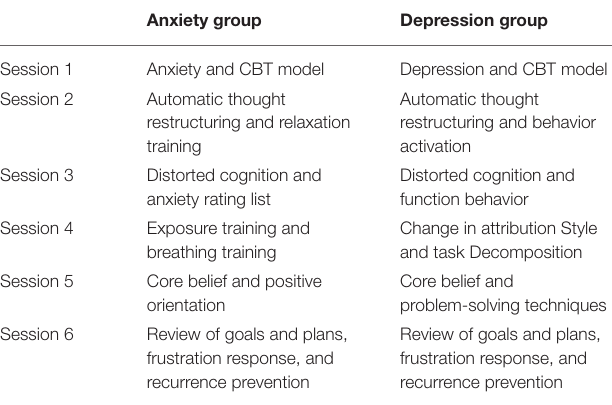
TABLE 2 | Comparison of demographic characteristics of CCBT platform users in the two